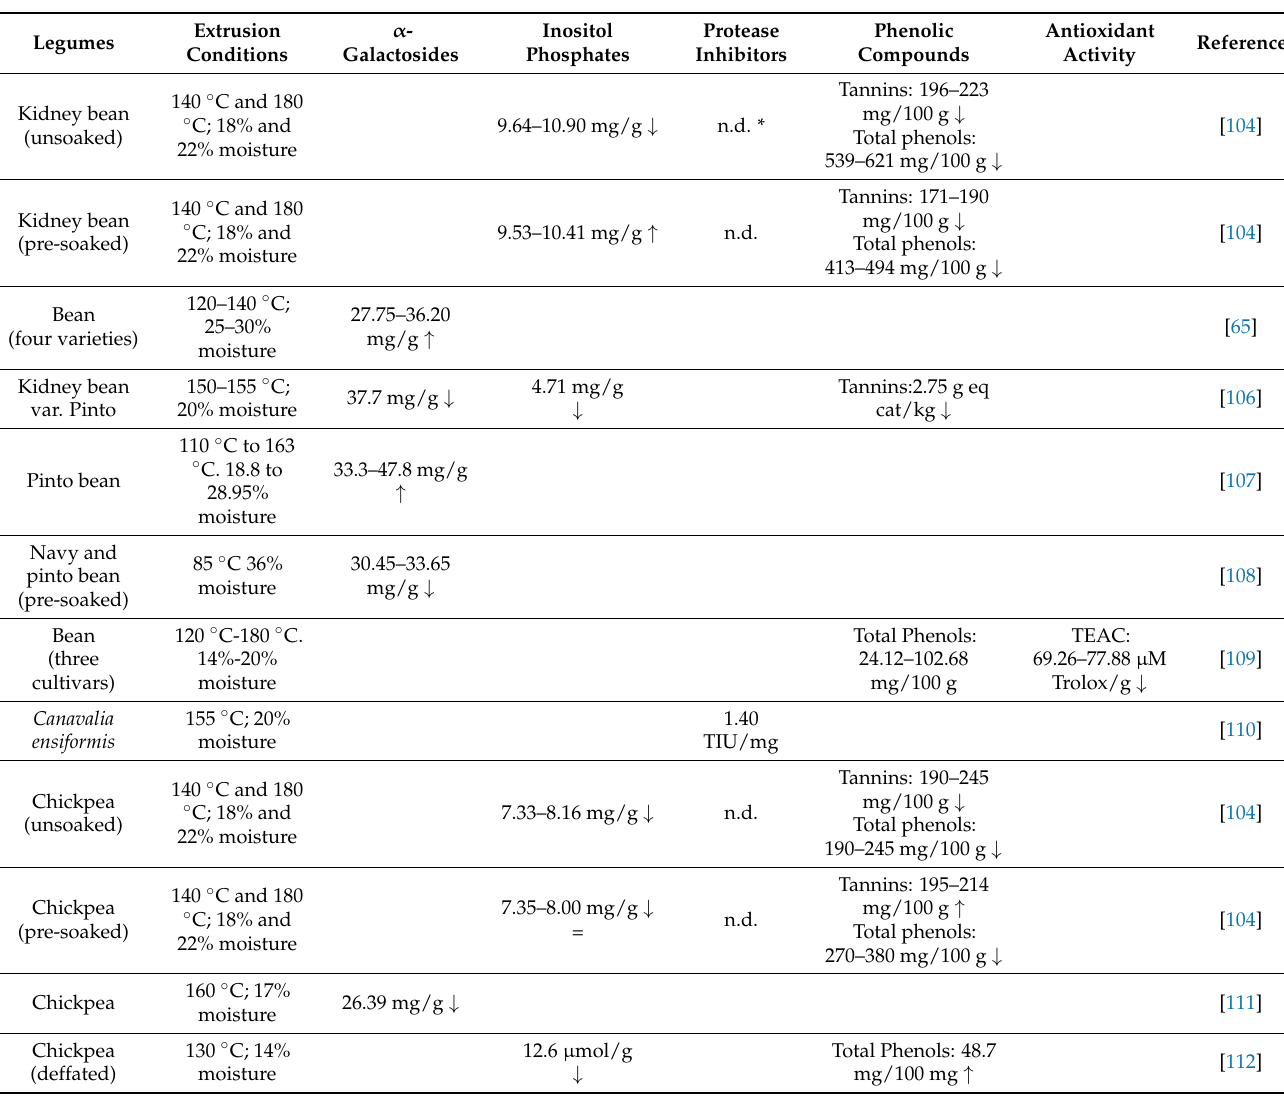
Table 2. Content of different bioactive compounds ( α -galactosides, inositol phosphates, protease inhibitors, phenolic compounds and antioxidant activity) in extruded